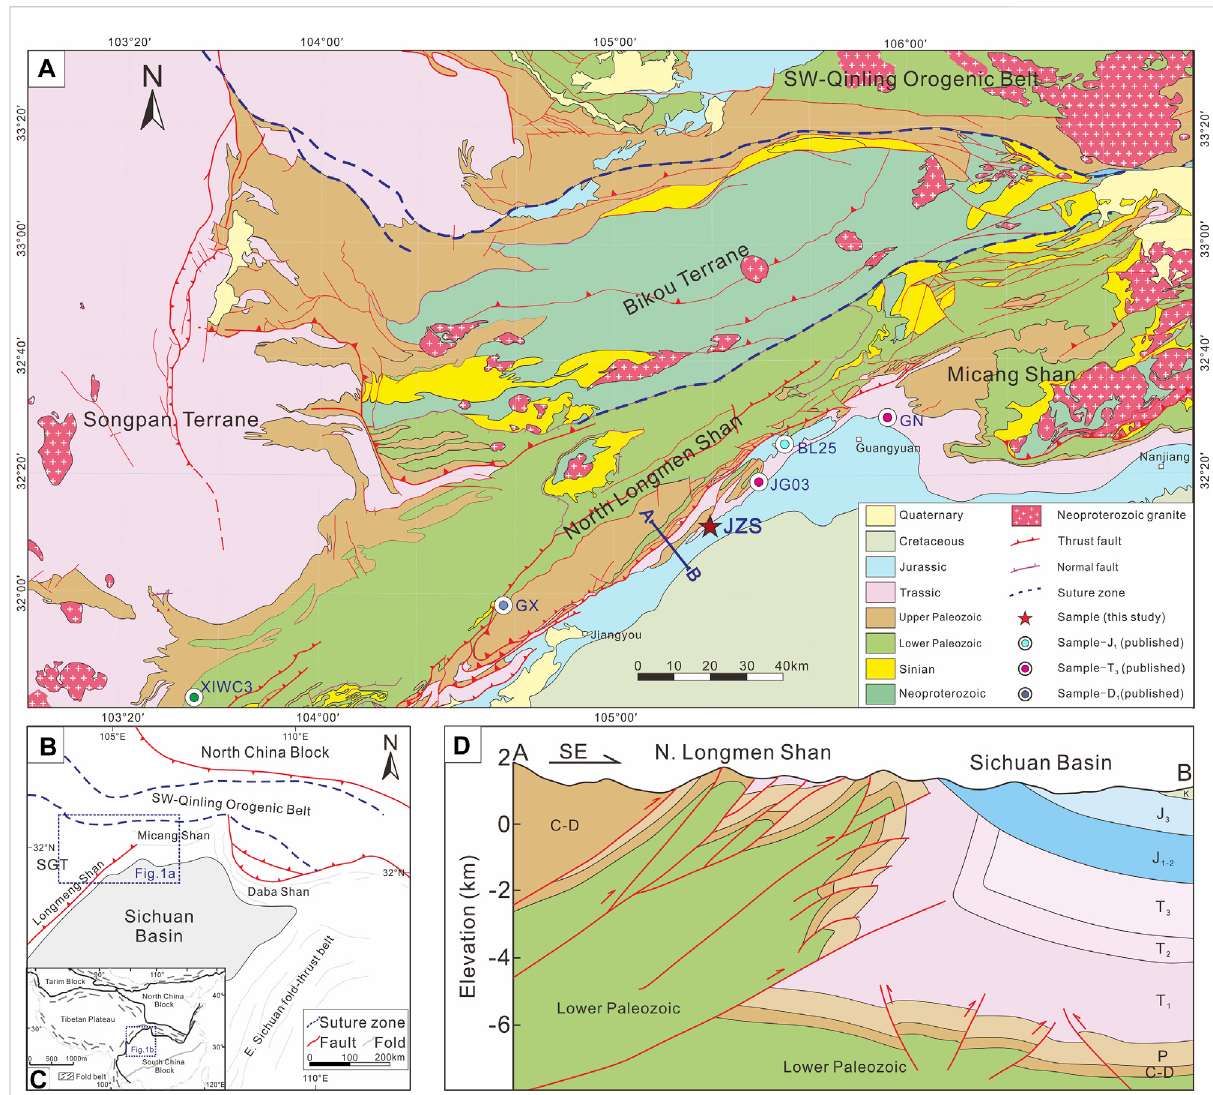
FIGURE 1 (A) Geological map of the northwestern Sichuan Basin and north Longmen Shan orogenic belt (adapted from Yan et al., 2018). The red star indicates the Jinzishan outcrop (JZS) analysed herein. (B) Tectonic setting of Sichuan basin and adjoining regions (adapted from Ma et al., 2019).